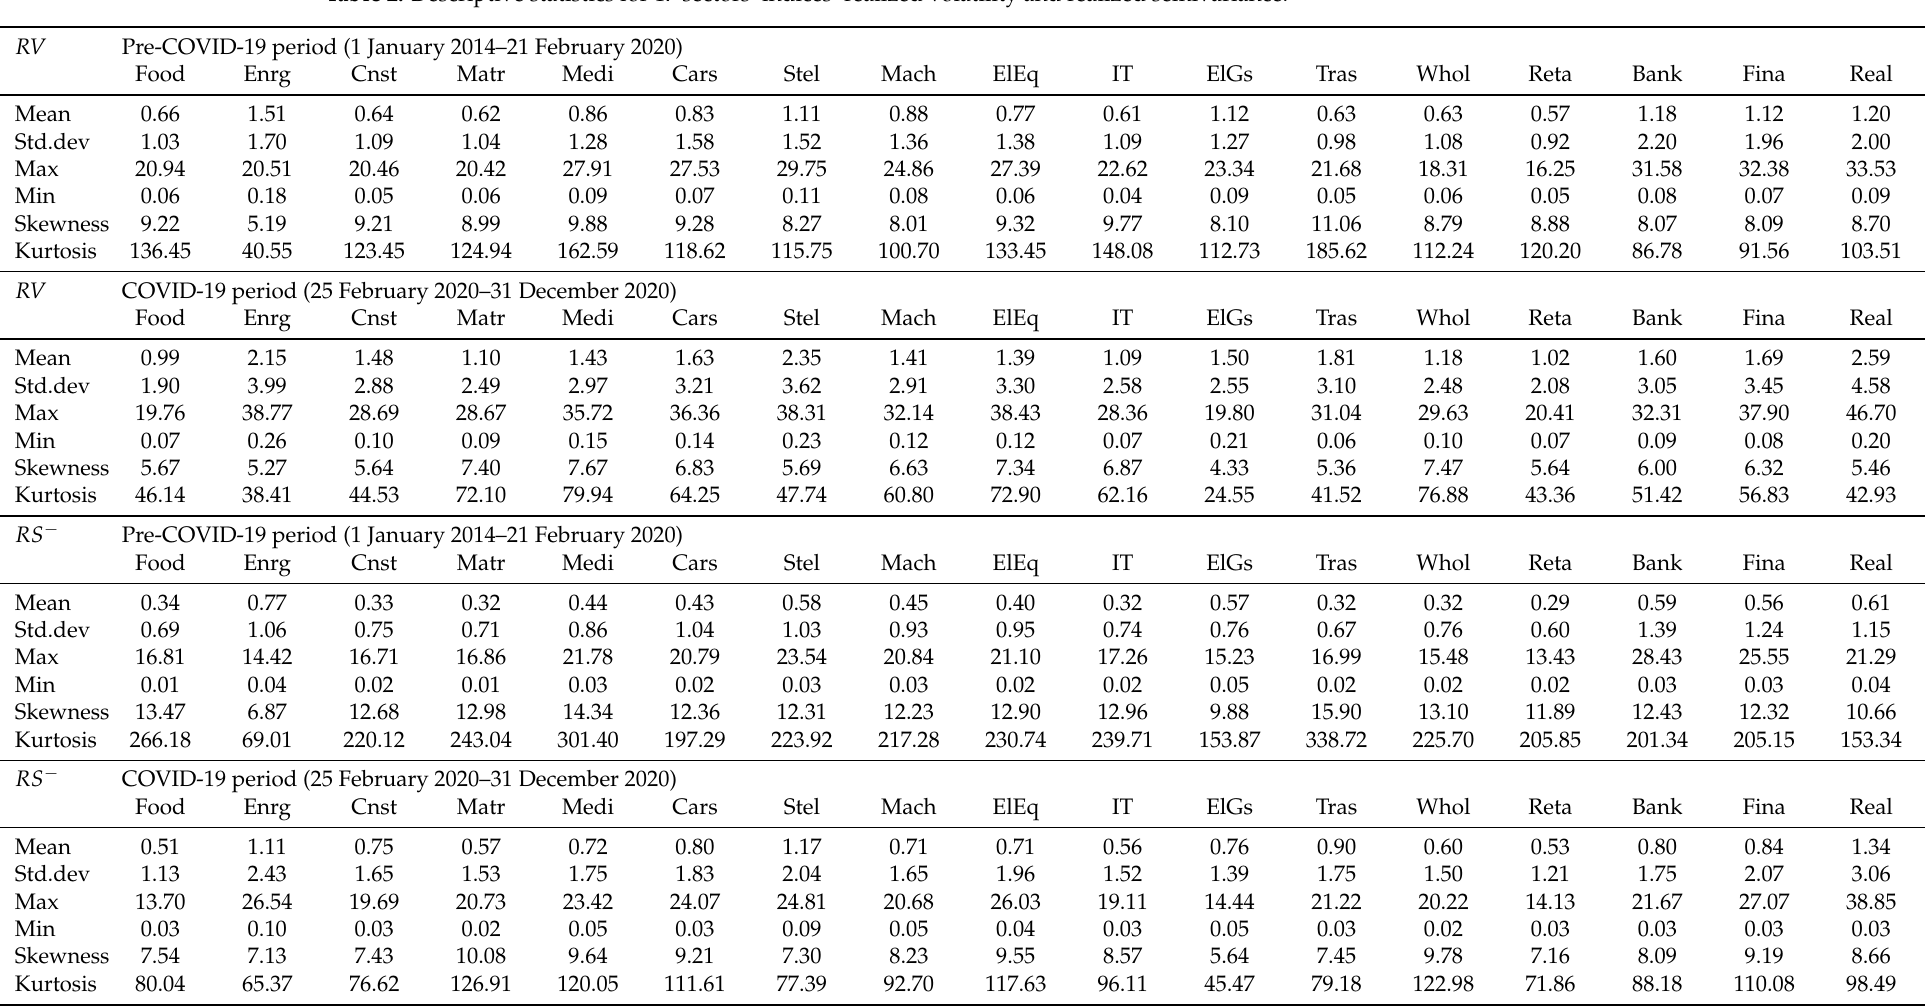
Table 2. Descriptive statistics for 17 sectors’ indices’ realized volatility and realized